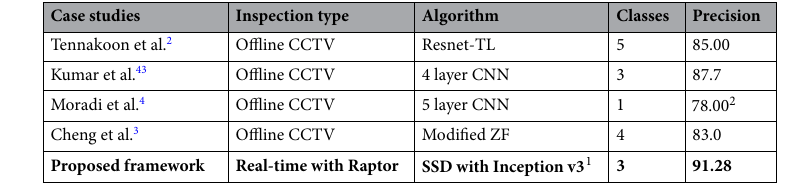
Table 5. Comparison analysis with existing object detection framework. 1 The bolded model is the our proposed framework used for real-time Raptor test. 2 The authors only reported the accuracy